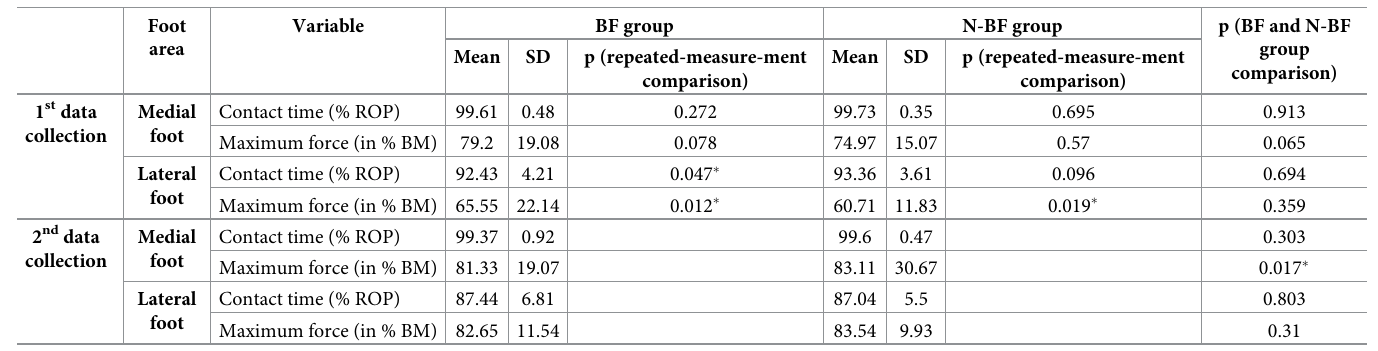
Table 6. Results of analysed gait parameters in the medial and lateral